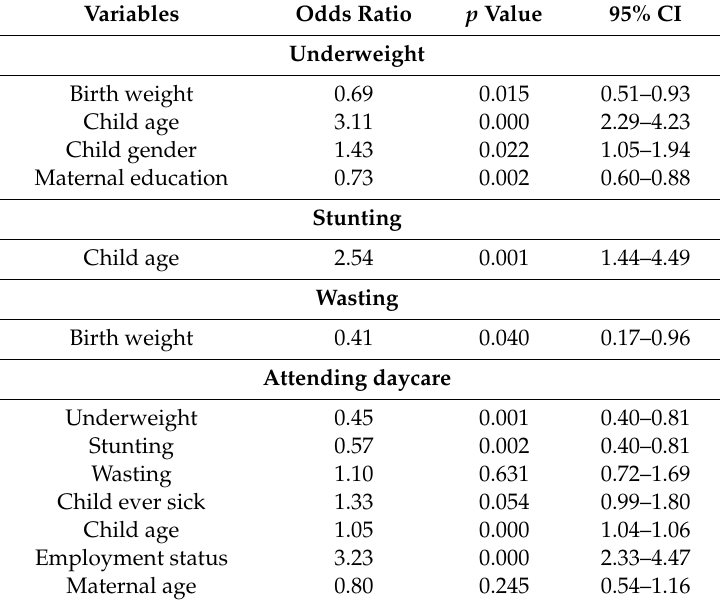
Table 4. Multivariable analysis of risk factors associated with undernutrition in children under five.